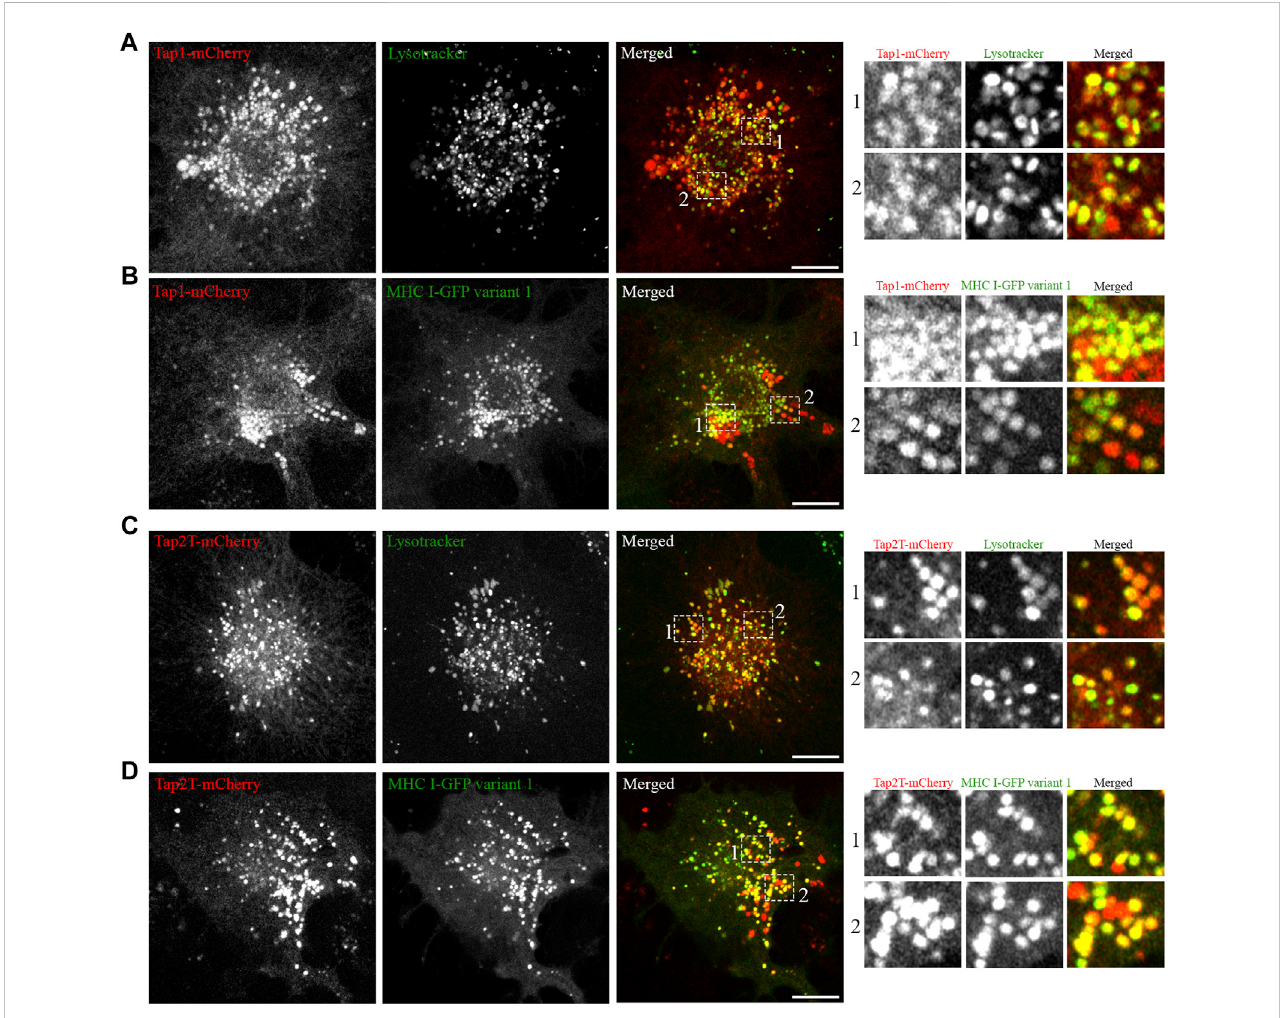
FIGURE 7 Atlantic cod PLC components Tap1 and Tap2T colocalize with MHC I variant 1 on endosomes. (A) Representative image of an ACL cell transiently transfectedwithcodTap1-mCherry(red),stainedwithgreenlysotrackerandimagedusingaZeissLSM880FastAiryScanmicroscope.Colocalizationbetween green and red channels results in yellow signal in the merged panels. Scale bar: 10 μ m. Magni fi cation of boxed areas show colocalization between Tap1- mCherry and green lysotracker. (B) Representative image of an ACL cell transiently co-transfected with Atlantic cod Tap1-mCherry (red) and MHC I variant 1-GFP (green) imaged using a Zeiss LSM880 Fast AiryScan microscope. Colocalization between green and red channels results in yellow signal in the merged panels. Scale bar: 10 μ m. Magni fi cation of boxed areas show colocalization between Tap1-mCherry and MHC I variant 1-GFP. (C) Representative image of an ACL cell transiently transfected with cod Tap2T-mCherry (red), stained with green lysotracker and imaged using a Zeiss LSM880 Fast AiryScan microscope. Colocalization between green and red channels results in yellow signal in the merged panels. Scale bar: 10 μ m. Magni fi cation of boxed areas show colocalization between Tap2T-mCherry and green lysotracker. (D) Representative image of an ACL cell transiently co-transfected with Atlantic cod Tap2T-mCherry (red) and MHC I variant 1-GFP (green) imaged using a Zeiss LSM880 Fast AiryScan microscope. Colocalization between green and red channelsresultsinyellowsignalinthemergedpanels.Scalebar:10 μ m.Magni fi cationofboxedareasshowcolocalizationbetweenTap2T-mCherryandMHC I variant